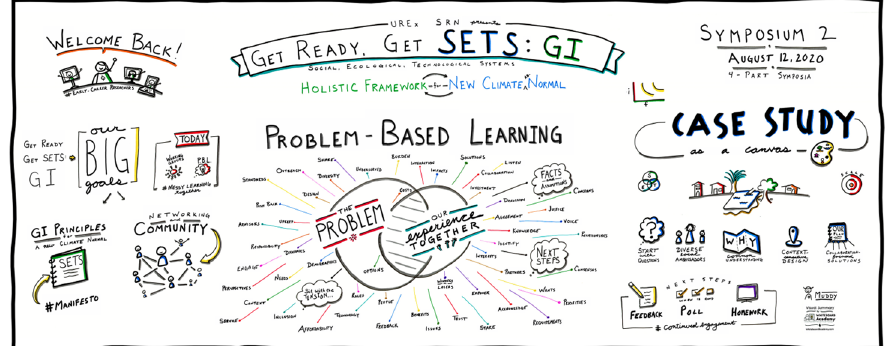
Fig. 4 A visual summary of Symposium 2, the launch of the problem-based learning scenario and case